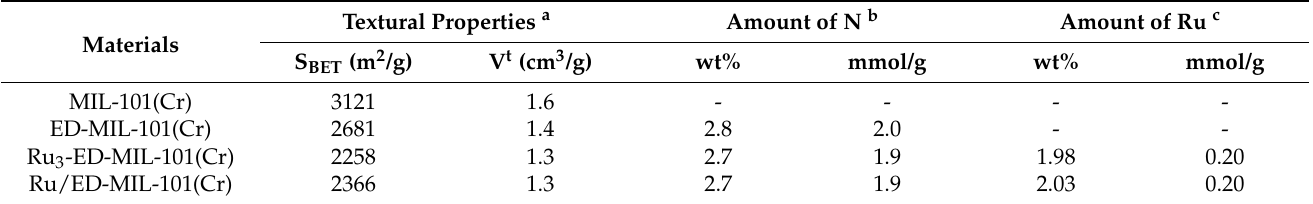
Table 1. Elemental composition and textural properties of the prepared